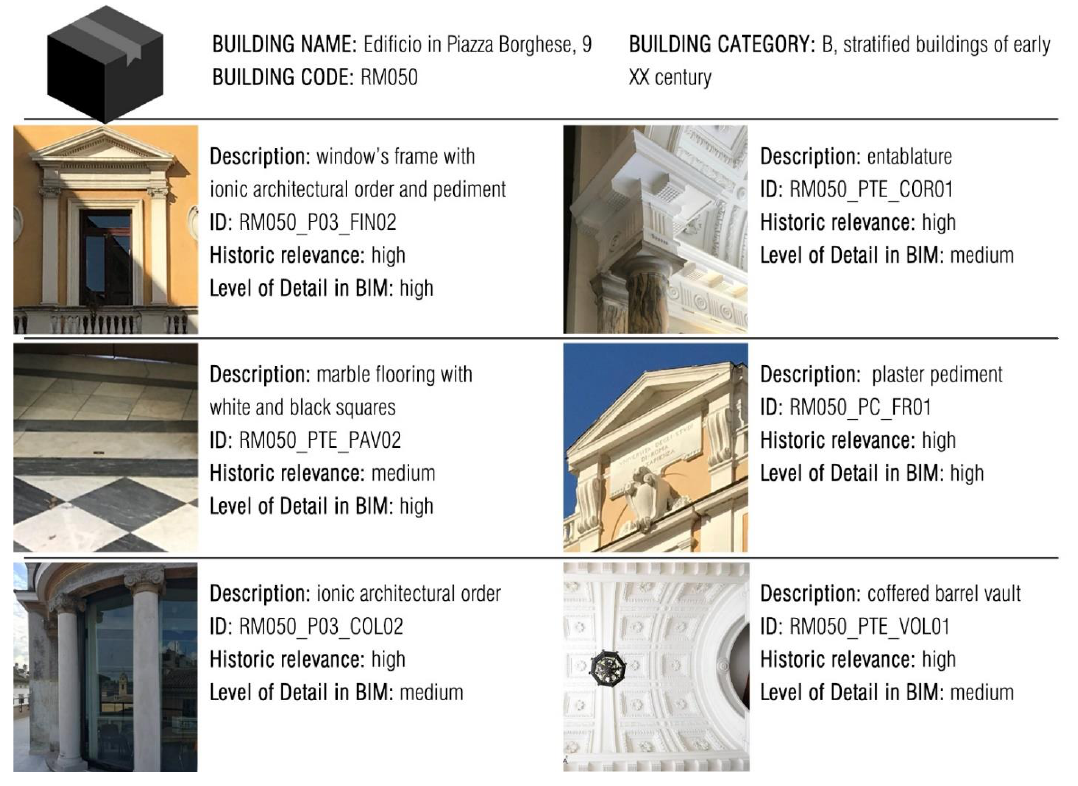
Figure 2. The building in Piazza Borghese, analysis, and classification of main architectural element.